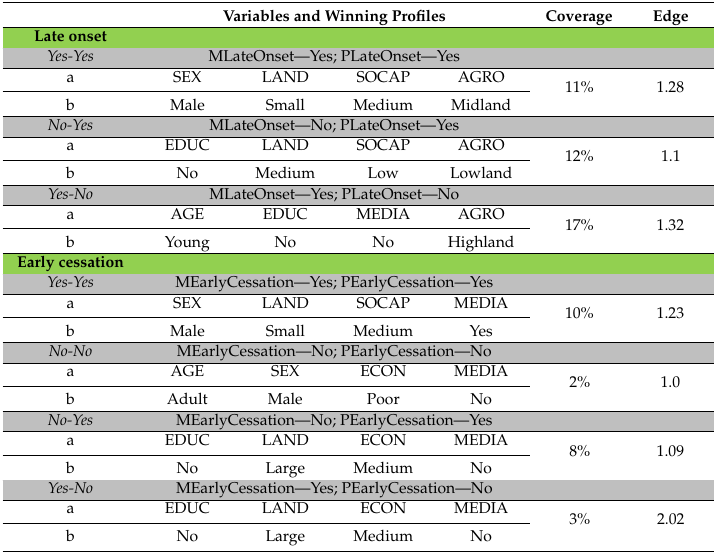
Table 9. Winning profiles of convergence and divergence between measurement and farmers’ perceptions of the time of onset and cessation of